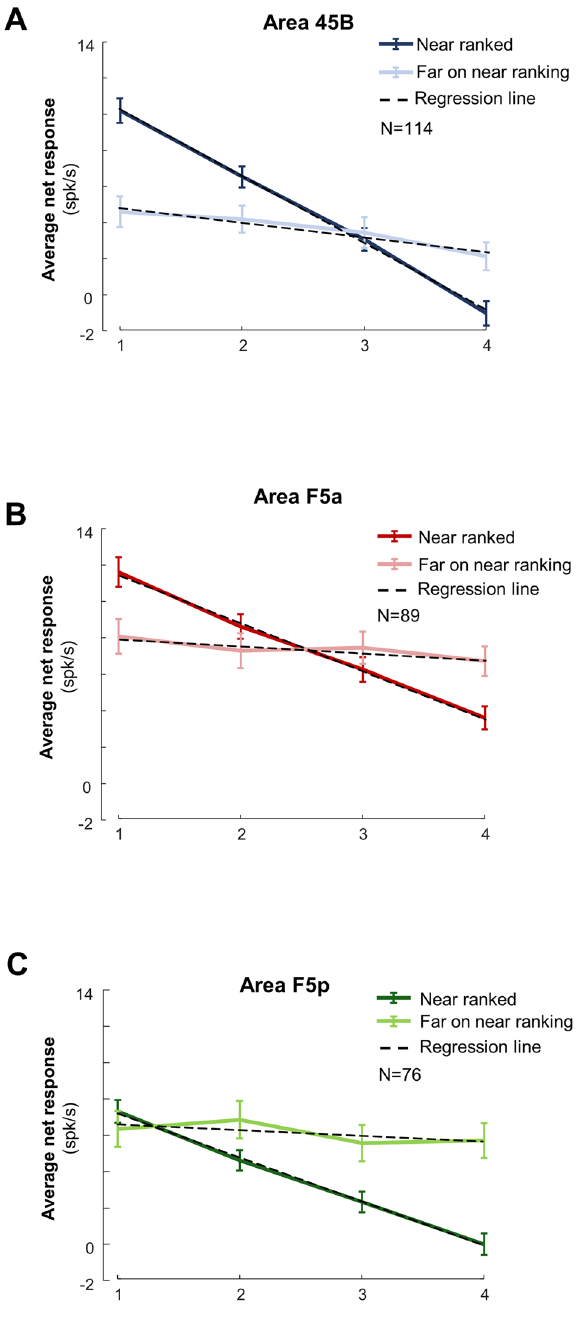
Figure 5. Ranking analysis: position tolerance across distances in depth. Average ranked responses at the Near position (dark color shades) and average responses to the same objects at the Far position (lighter color shades), for area 45B (blue; A ), F5a (red; B ) and F5p (green; C ). Error bars of same colors represent sem. See also Supplementary Fig. 3, for Monkey D and Y,